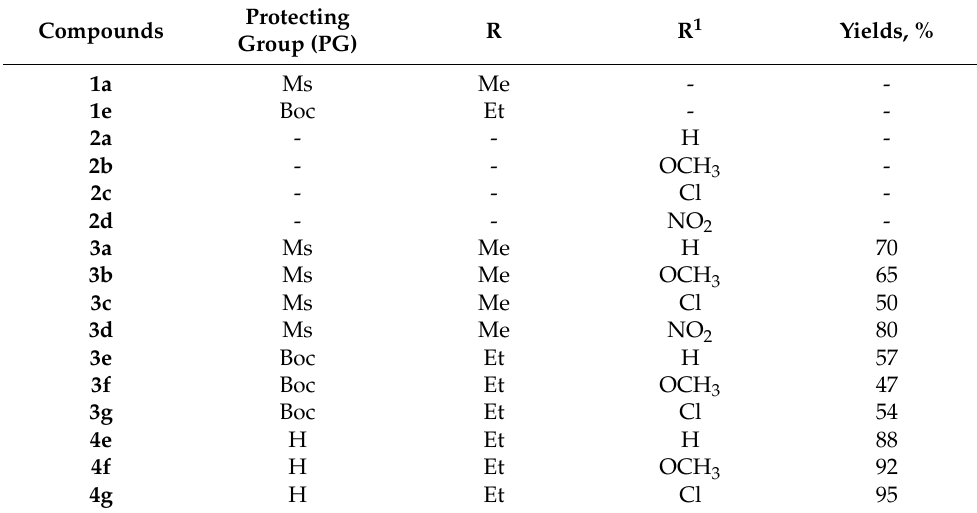
Table 1. Reagents 1a,e , 2a-d, and synthesized products 3a-g and 4e-g . Compounds